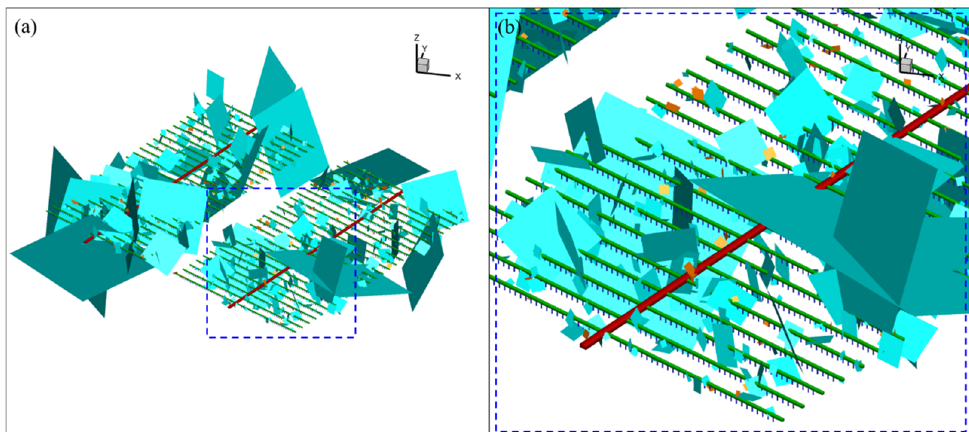
Figure 5. The example DFN realization using the DFN recipe and the repository. ( a ) The fractures that intersect the repository are divided into connected (in light blue color) and isolated fractures (in orange color). It is also noted that colors are influenced by light and shade; ( b ) The close view of the MT (in red color), DT (in green color), the connected fractures (in light blue color), and isolated fractures (in orange color).